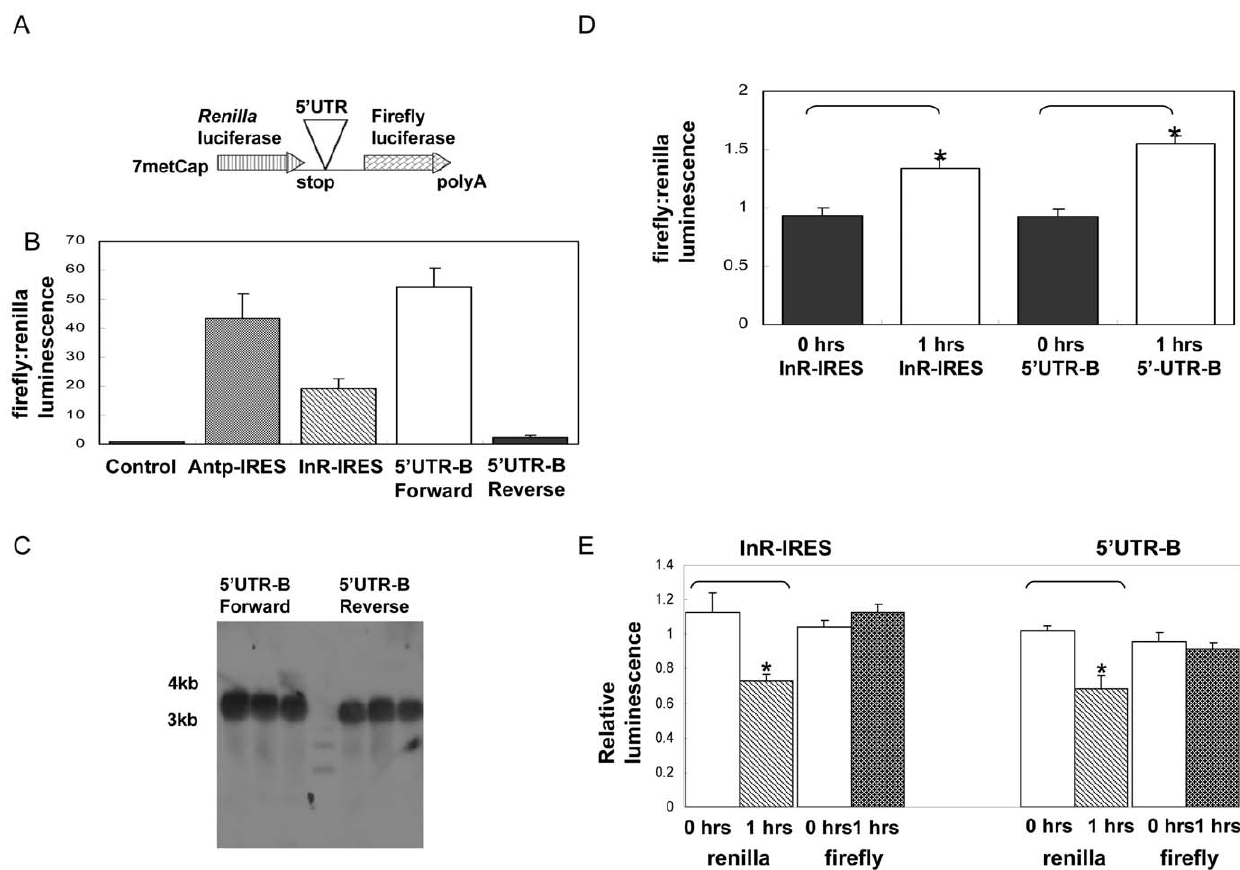
Figure 3. Translation from dfoxO -IRES and dInR -IRES when fasting represses cap-dependent translation of S2 cells. ( A ) Scheme of the di-cistronic reporter construct. Translation from 5 9 cap is quantified by renilla luminescence. Translation from the IRES of the same cells is quantified from firefly luminescence. ( B ) Ratio of firefly-to renilla luminescence of dInR-IRES , Antp-IRES and dfoxO -5 9 UTR-B in forward and reverse orientation. ( C ) Northern analysis from S2 cells transfected with the di-cistronic renilla-fifefly luciferase reporter with dfoxO -5 9 UTRB firefly luciferase inserted in forward and reverse orientation. Transfections were done in triplicate. The probe used is specific to firefly luciferase. ( D ) Ratio of firefly to renilla luminescence of dInR-IRES and dFoxO-5 9 UTR transfected cells before (0 hours) and after fasting (1 hour). ( E ) Renilla and firefly luminescence of dInR - IRES and dfoxO -5 9 UTR in transfected cells before fasting (0 hours) and after fasting (1 hour). Data are shown as the mean + 1SD for duplicates determinations. *, P , 0.05 versus 0 hrs of